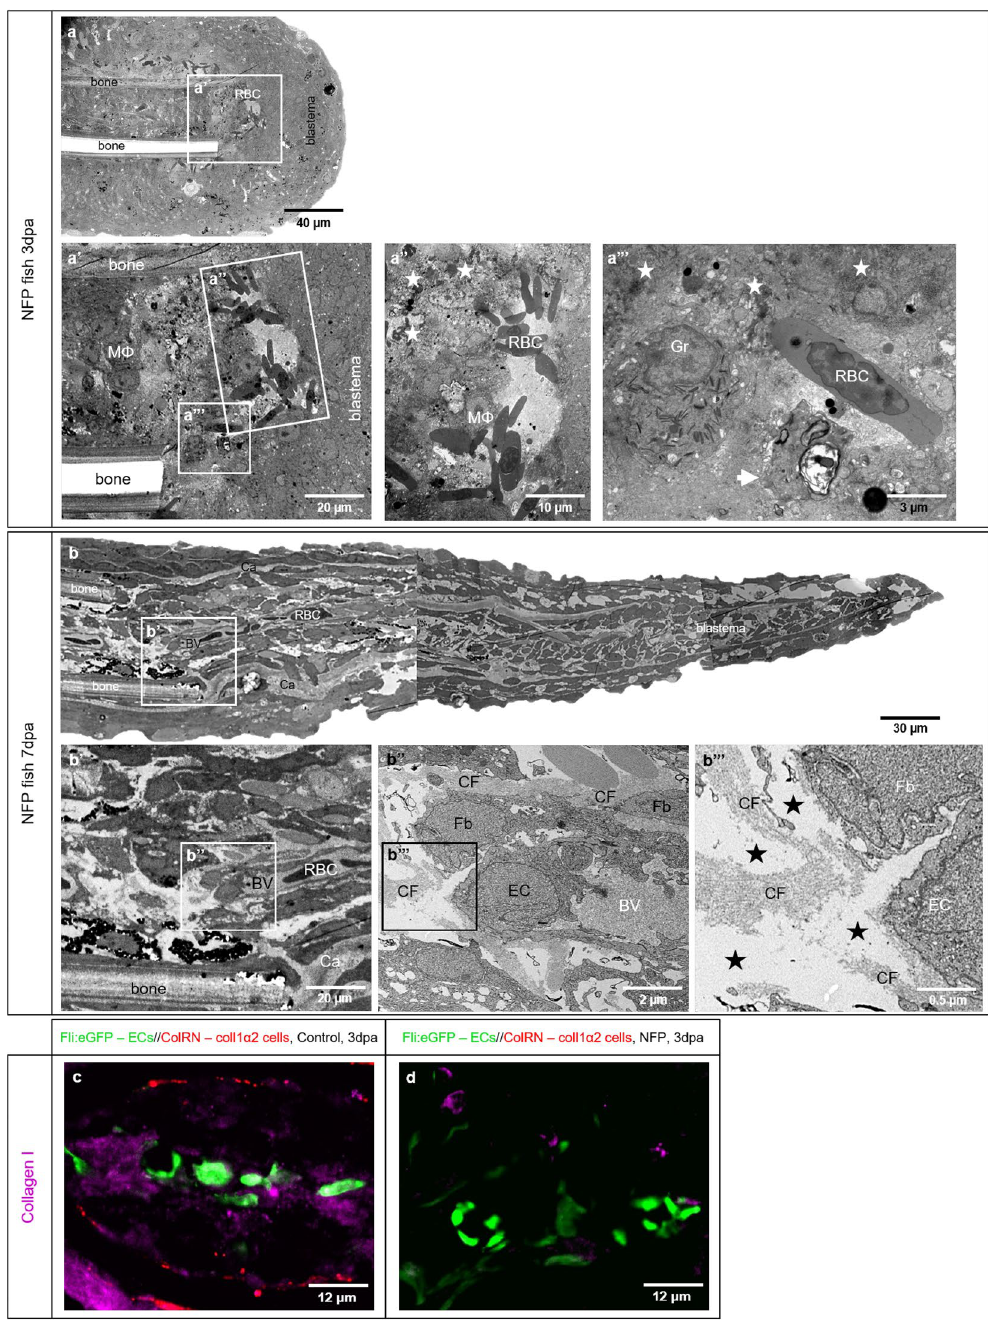
Figure 7. NFP treatment causes collagen deficiency and impairment of caudal fin regeneration. Electron microscopy performed on longitudinal sections revealed severe structural alteration after NFP treatment. 3dpa ( a ) and 7dpa ( b ) represented overview of the fish ray containing bones, RBCs deposition and blastema. a’ – a’’’ display clusters and single RBCs that are in direct contact with surrounding macrophages MΦ, and areas of atypical, amorphous ECM. The latter contains disintegrated cells and cell debris (asterisk) as well apoptotic cells ( a’’’ , arrow). In contrast to the controls and BAPN treatment, granulocytes (Gr) and MФ are common features. Classical collagen fibers are not detectible. Amputation plane at 7dpa containing perfused vessels is displayed in b ; the endothelial coverage is partially interrupted; the EC are activated containing round nuclei and multiple intravascular protrusions. ECM contains less collagen fibers (CF), those do not build classical bundles. The intercellular space is loose, amorphous with irregular distribution representing electron microscopically “empty areas” ( b’’’ , asterisks). Immunofluorescence staining on transversal sections at the amputation site in control animal ( c ) and NFP-treated animal ( d ) at 3dpa are documented. Blood vessels (ECs) are labeled in green, active collagen 1α2 producing cells in red and collagen I purple ( c ). c demonstrates intact blood vessels, active collagen 1α2 producing cells, and accumulation of collagen I in the vicinity of the blood vessels. d displays blood vessels, very tiny scattered fragments of collagen I and absence of active collagen 1α2 producing